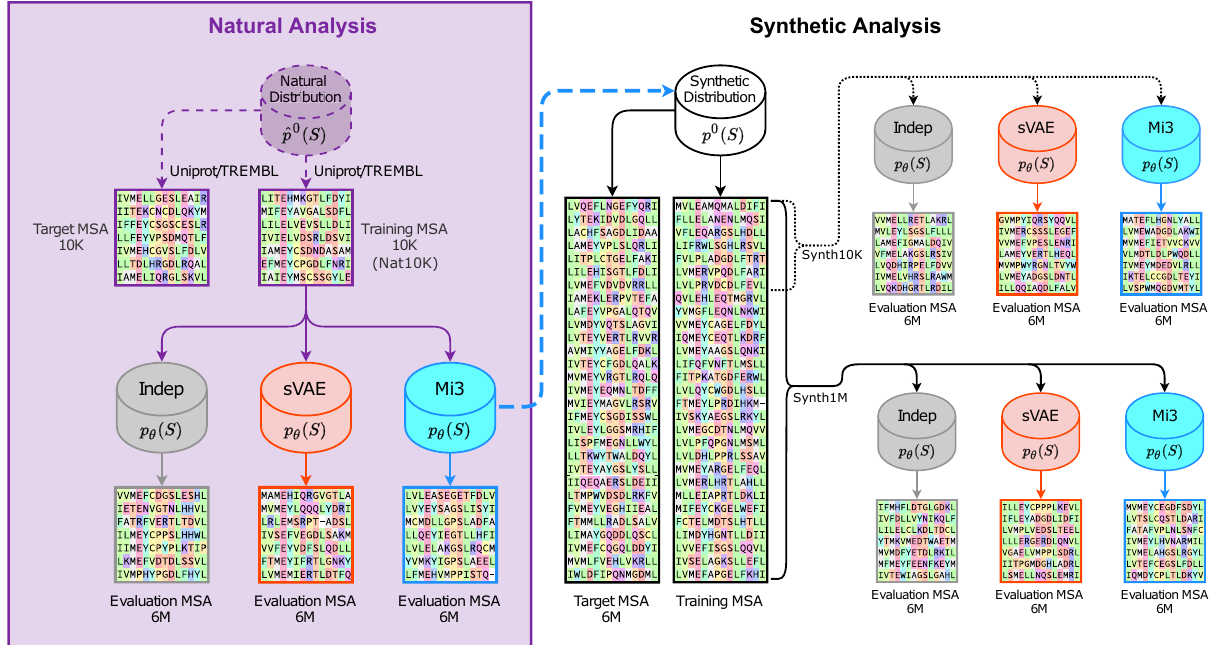
Fig. 1 Work fl ow of natural and synthetic analyses. We perform two analyses, one Natural (left, purple) and the other Synthetic (right, black). In both analyses, we train three types of GPSMs on protein MSAs, which are Indep (gray), VAEs (orange), and Mi3 (blue). Because the performance of both VAEs tested (sVAE and DeepSequence) perform equivalently, only sVAE is included in this fi gure for simplicity. To compare performance across GPSMs, we generate an evaluation MSA of 6M synthetic sequences from each GPSM after training, and test generative capacity by comparing the evaluation MSA to the target MSA. The target MSA is non-overlapping with the training MSA, but was sampled from the same target probability distribution. Left: In the Natural Analysis, we train the GPSMs on 10 K protein sequences (Nat10K) taken from Uniprot/TREMBL. The natural target probability distribution (purple) is unknown, so we demarcate its container with a dashed line and de fi ne it as ^ p 0 ð S Þ to emphasize this unique property, in contrast to all other probability distributions which we know exactly. The dashed lines leaving the Natural Distribution indicate that the non-overlapping 10K training and target MSAs are the result of aligning and phylogenetic fi ltering of sequences obtained from Uniprot/TREMBL. In the Natural Analysis, we are data-limited to ~10K samples for the non-overlapping training and target MSAs. Right: In the Synthetic Analysis, we use a known Synthetic Distribution, p 0 ( S ), from which we can generate arbitrarily large MSAs. The dashed blue line pointing to the Synthetic Distribution is to emphasize that it is precisely the Mi3 GPSM distribution constructed in the Natural Analysis. In one experiment (top right), we train the GPSMs on only 10K synthetic sequences (Synth10K) to mimic the Natural Analysis. However, we perform generative capacity measurements on a target MSAs of 6M sequences, removing estimation error from the measurements. In the second experiment (bottom right), we train the GPSMs on 1M training sequences (Synth1M), which include the 10K from the fi rst experiment. With these large training and target MSAs, both out-of-sample and estimation error are removed from the generative capacity measurements, leaving only speci fi cation error, if